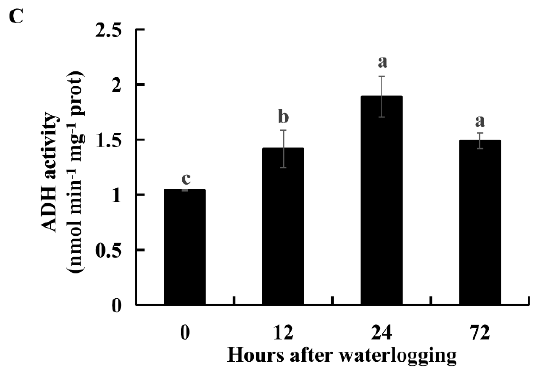
Figure 6. Changes of expression levels of two DEGs encoding ADH and ADH activity in KR5 roots under waterlogging stress. ( A ) RNA-Seq (right vertical axis) and qRT-PCR (left vertical axis) results for transcript changes in i1_LQ_K_c67155/f1p0/1459 ( ADH1 ); ( B ) RNA-Seq (right vertical axis) and qRT-PCR (left vertical axis) results for transcript changes in i1_LQ_K_c38965/f1p0/1342 ( ADH2 ); ( C ) ADH activity. In ( C ) data are expressed as averages ± SD, n = 3 and significant differences between treatments at p < 0.05 are indicated by different letters over columns (Duncan’s test).